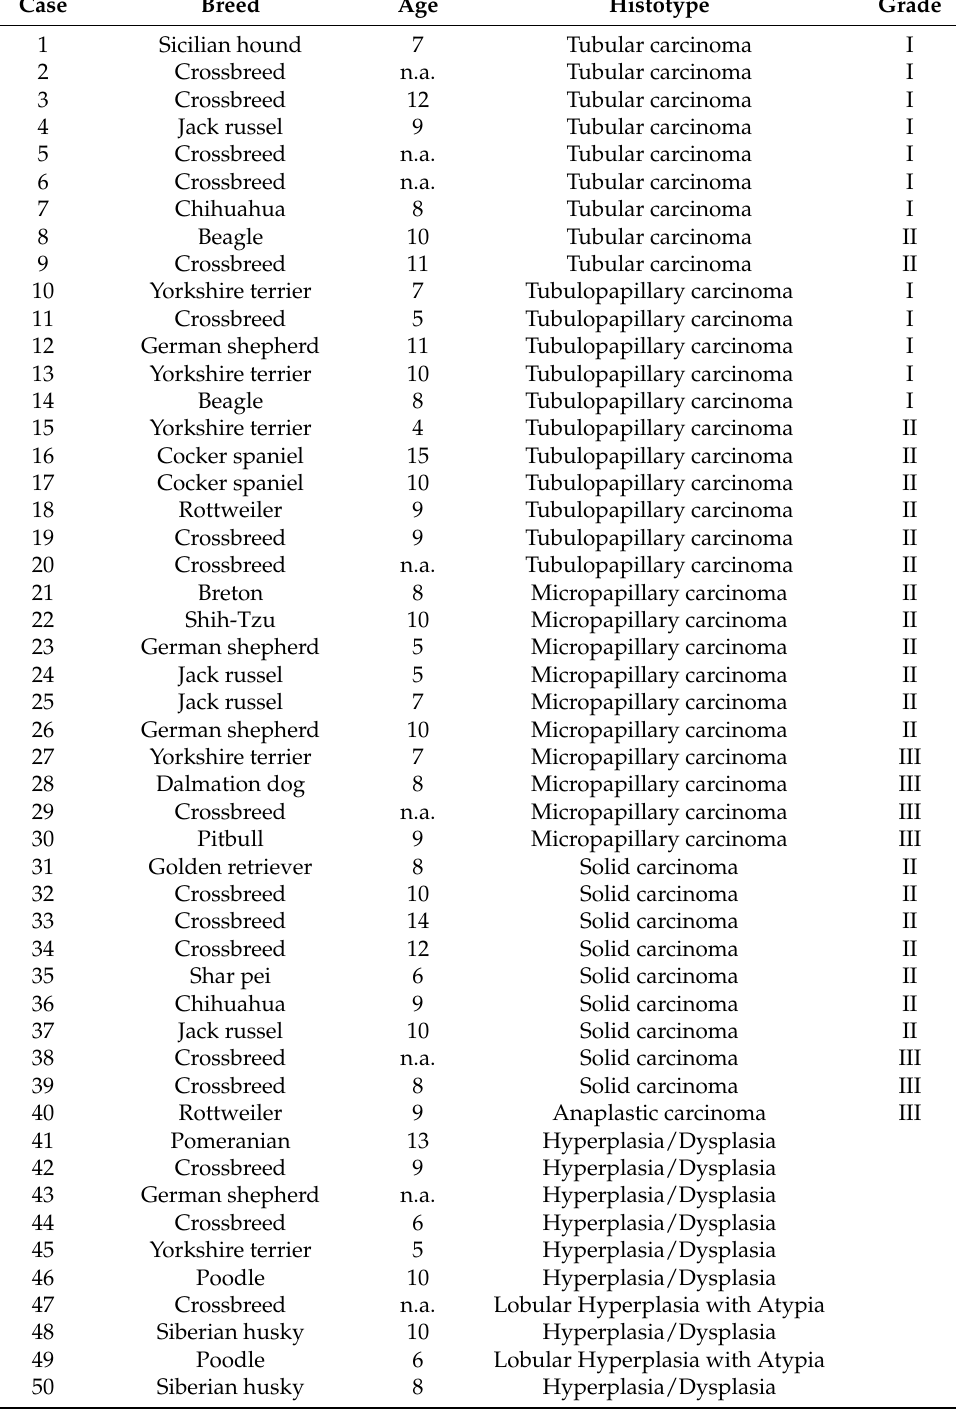
Table 1. List of cases considered (n.a. not